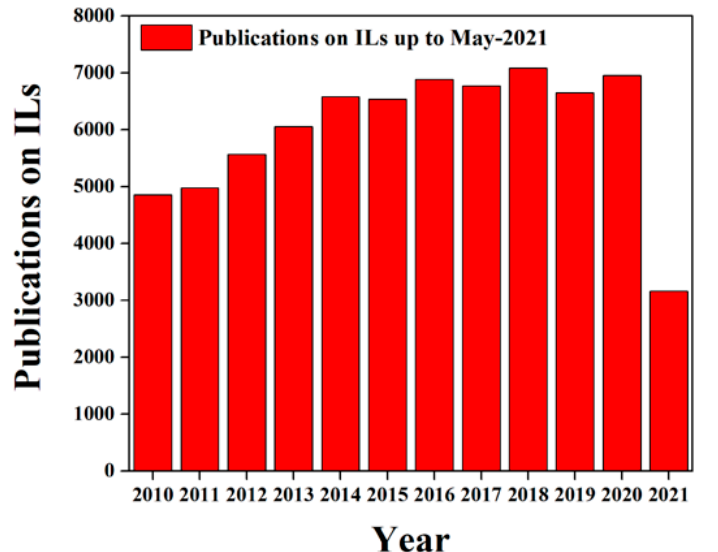
Figure 2. The number of publications in the area of ILs from 2010 to 2021 (All data are recorded from “Scopus” up to 22nd of May 2021).